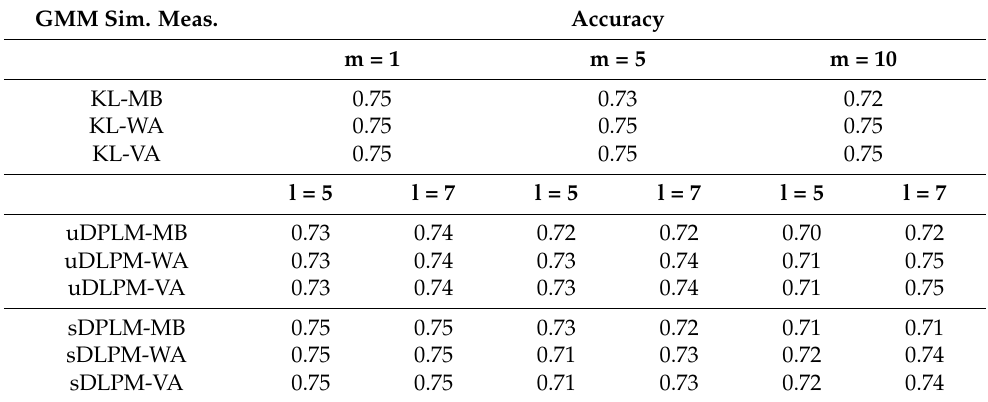
Table 3. Recognition accuracies for DPLM-based and KL-based measures on the UMD database. GMM Sim.